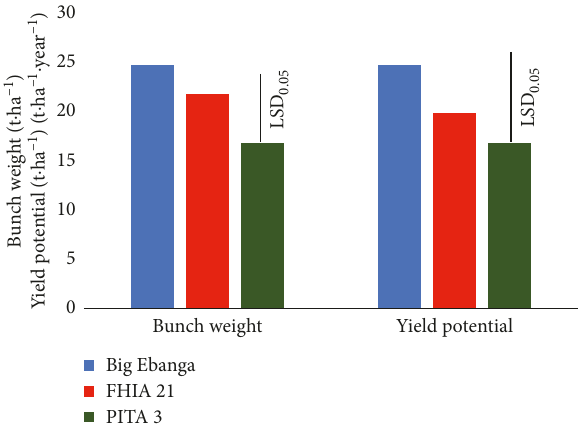
1 ) and yield potential (bunch weight Figure 5: Bunch harvest (t ha · ha 1 ) of medium-sized tetraploid plantain hybrids FHIA 21 − (growth cycle: 13months) and PITA 3 (growth cycle: 12months) along with giant false horn plantain “Big Ebanga” (growth cycle: 12months) recorded in 120m 2 plots at Bobo Dioulasso, Burkina Faso.